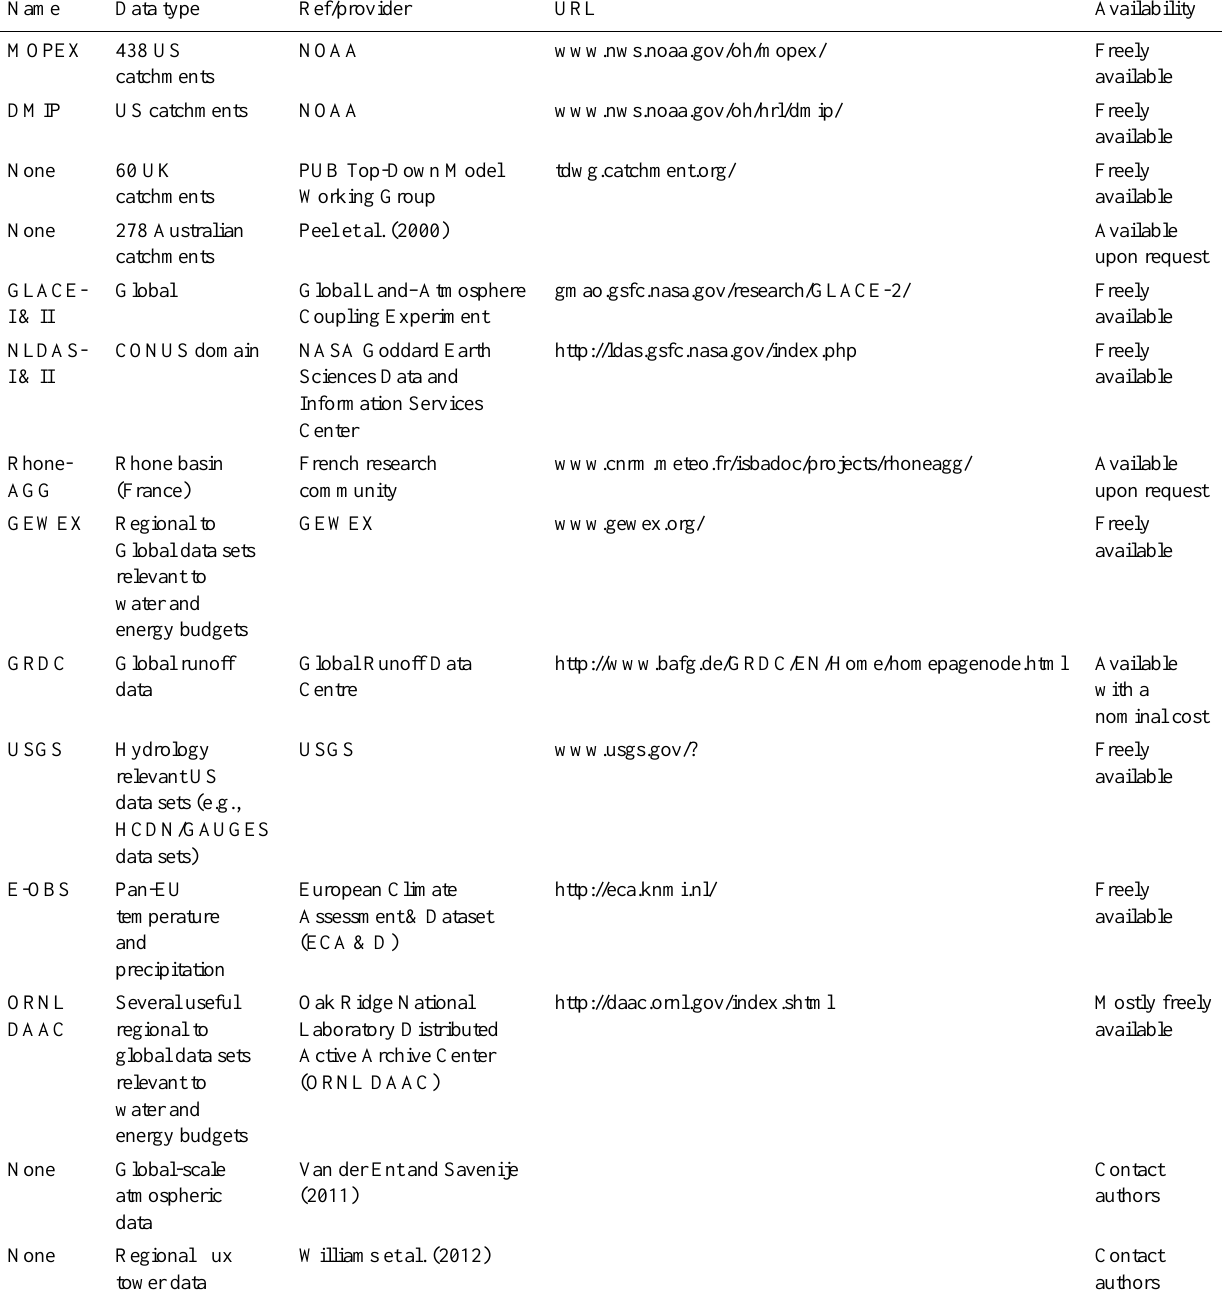
Table 1. Examples of data sets potentially useful for large-sample hydrological